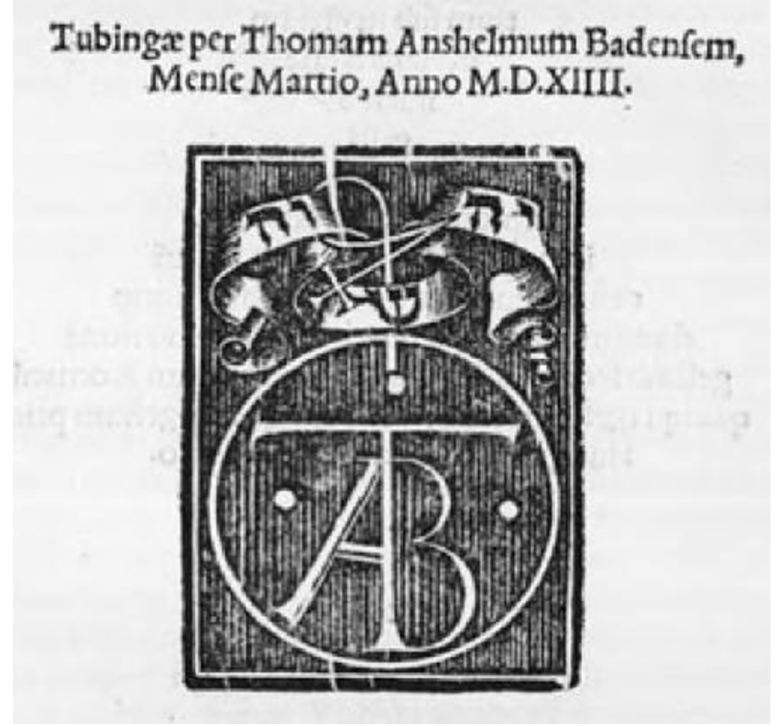
Figure 4. Johann Reuchlin, Epistolae Obscurorum Virorum , last folio with the stamp printing of Thomas Anshelm of first edition, Tubingae,